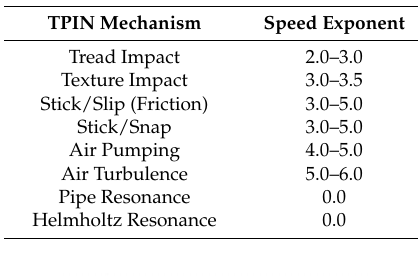
Table 2. Speed exponents for different TPIN mechanisms (modified from Kuijpers and van Blokland, 2001 [14], Figure 1).